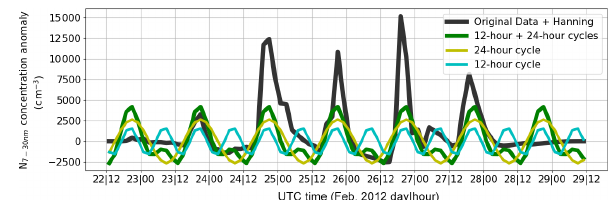
Figure 13. N 7 − 30nm for the weekly data chunk that had the high- est power associated with the 12h cycle (22–29 February 2012). The aerosol data are shown as a concentration anomaly from the seasonal mean (black). The anomaly data are broken down into the 12h cycle component (cyan), the 24h cycle component (yellow), and the combination of the 12 and 24h cycles (green), as computed by the power spectral